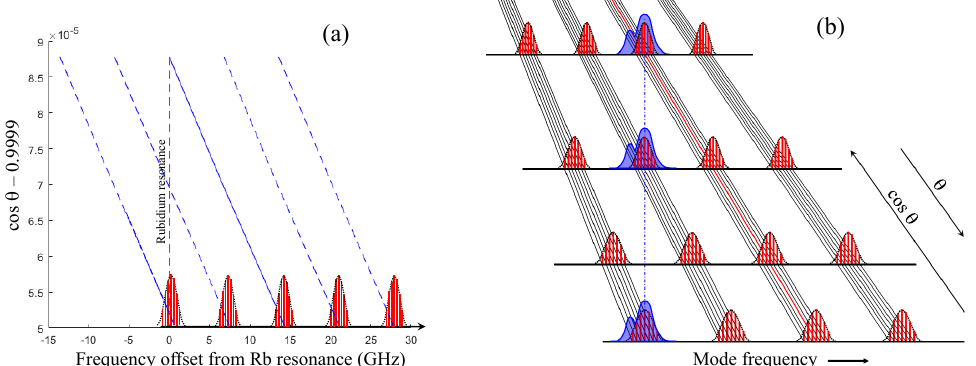
Figure 9. Evolution of the frequency of the mode comb teeth versus etalon angle. ( a ) The position of the center of each group of modes is plotted versus the cosine of the internal angle θ of the Fabry–Perot. θ = 0 corresponds to normal incidence. The resonance the modes with the D line of 87 Rb is taken as frequency origin. ( b ) Sketch illustrating the tuning of the comb structure with the Fabry–Perot angle. The purple area indicated the spectrum of the rubidium